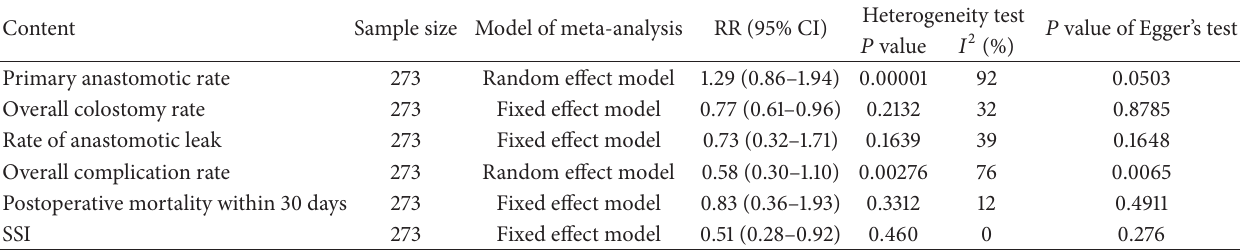
Table 3: Result of meta-analysis.